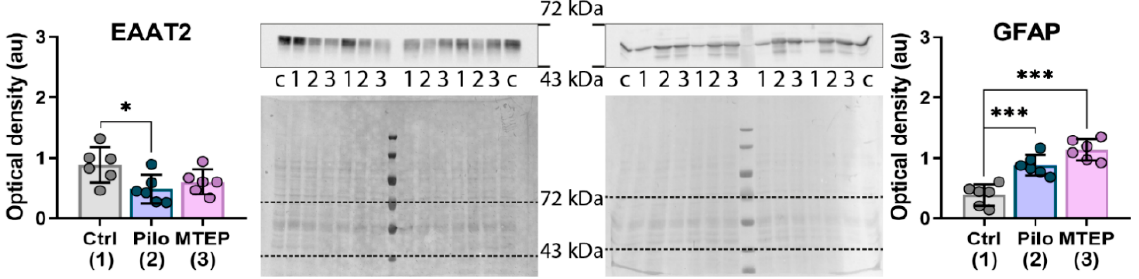
Figure 7. Western blotting data of proteins production in the dorsal hippocampus 7 days after pilocarpine-induced SE. For inserts, the upper part shows the chemiluminescent signal, the lower part shows the Ponceau S. For bands c is sample calibrator, 1 is Ctrl, 2 is Pilo, and 3 is MTEP group. Each dot represents one animal; the columns indicate average values and error bars show standard deviations. One-way ANOVA, GFAP: F 2,17 = 29, p < 0.001; EAAT2: F 2,17 = 4, p < 0.05. Asterisks indicate significant differences between groups according to Tukey’s post hoc tests: * p < 0.05, *** p <